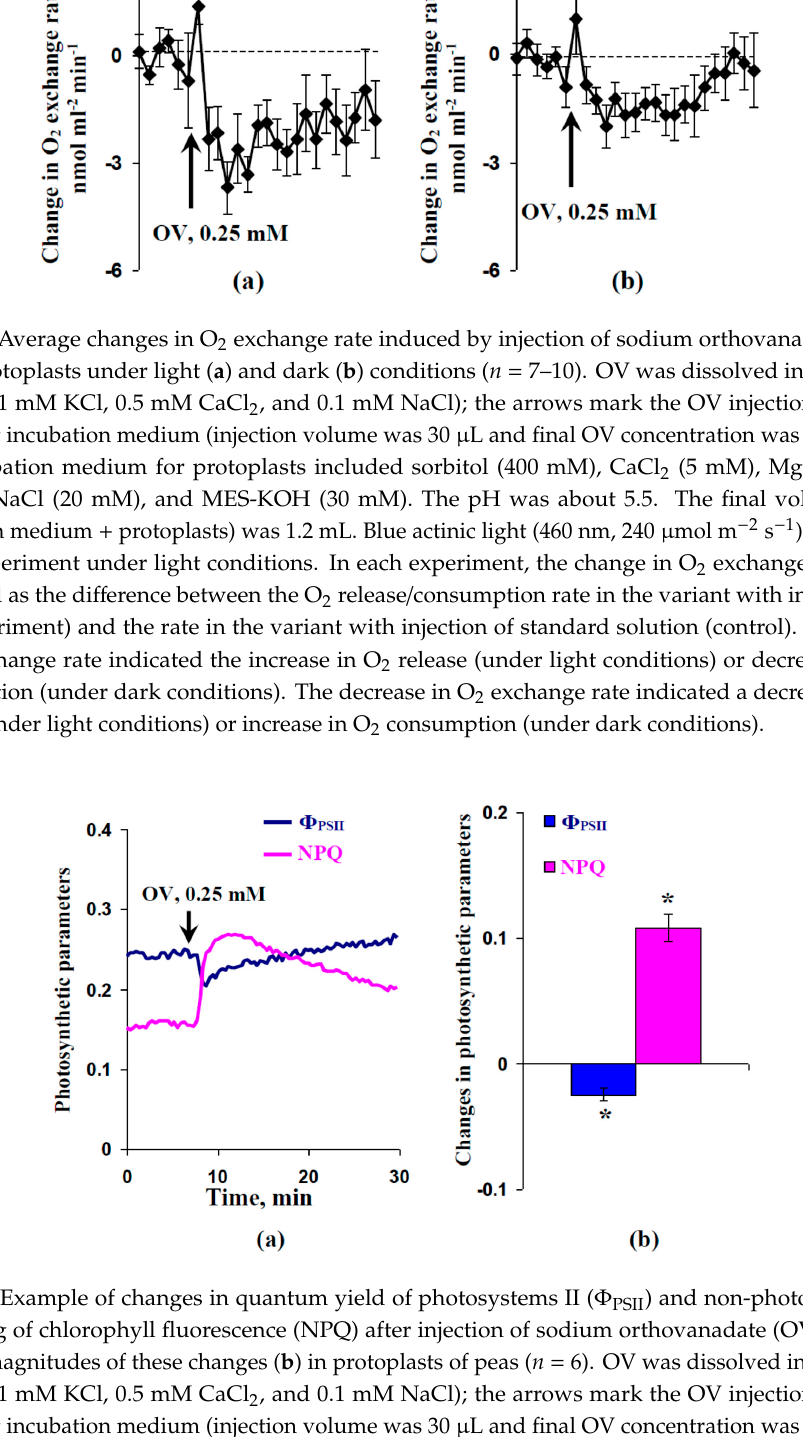
9 of 21 Figure 7. Magnitudes of local burning-induced changes in respiration (R CO2 ) ( a ) and scatter plot between the values of the metabolic component of the membrane potential and the magnitudes of these changes ( b ) ( n = 5–6). Respiration was measured under dark conditions. The preliminary OV (0.5 mM) and FC (1 µM) treatments of the second mature leaves in seedlings were performed by incubation of the leaf (2 h) in solutions of these chemical agents. After that, these leaves were dried using filter paper and used for respiratory measurement. OV and FC were dissolved in standard solution (1 mM KCl, 0.5 mM CaCl 2 , and 0.1 mM NaCl). Similar incubation in the standard solution was used as a control. The first mature leaf was burned (flame, 2–3 s). The values of the metabolic component were taken from Figure 1. *, significant difference between experiment and control plants ( p < 0.05). 2.5. Influence of Injection of Sodium Orthovanadate on Photosynthesis and Respiration of Protoplasts Protoplasts, which were isolated from leaf of pea seedlings, were used for additional analysis of the participation of H + -ATPase in the plasma membrane on the induction of photosynthetic and respiratory responses after local damage and propagation of VP. The influence of the OV injection (final concentration of sodium orthovanadate was 0.25 mM) on the O 2 exchange rate of protoplasts was investigated. Figure 8a shows that this injection induced